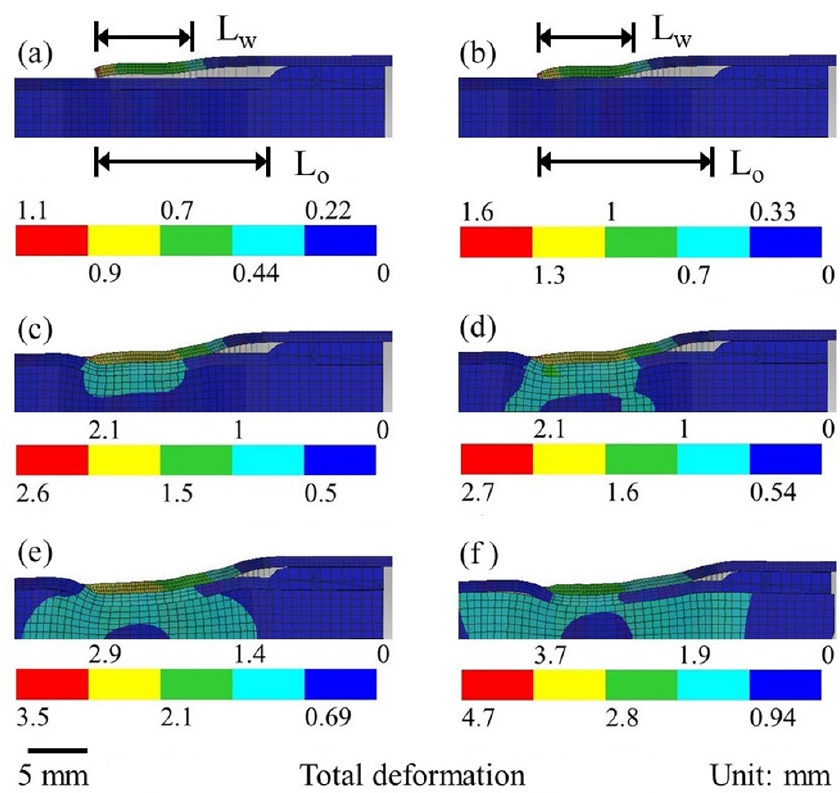
Figure 10. Computed results of the progressive impact and plastic deformation of the tube assembly at the time instants of ( a ) 9 µs, ( b ) 11 µs, ( c ) 15 µs, ( d ) 17 µs, ( e ) 21 µs and ( f ) 26 µs for an applied discharge energy of 14 kJ and with a polyurethane internal support for the target tube. (Initial conditions: wall thicknesses of the flyer = 0.89 mm and of the target = 1 mm; standoff distance between the flyer and the target = 1 mm; overlapping width between the field shaper and the flyer, L w = 8 mm and free length of the flyer tube, L o = 15 mm).